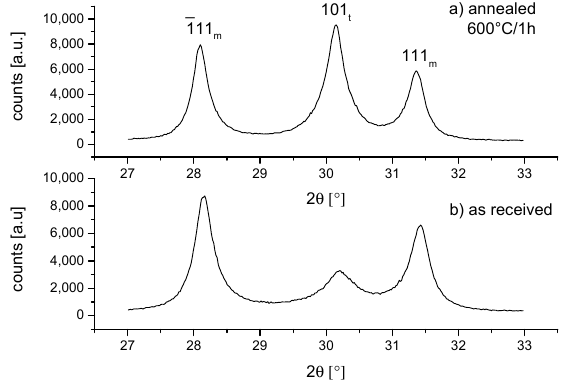
Figure 7. XRD traces of ( a ) annealed and ( b ) as-received 2Y-TZP starting powder.